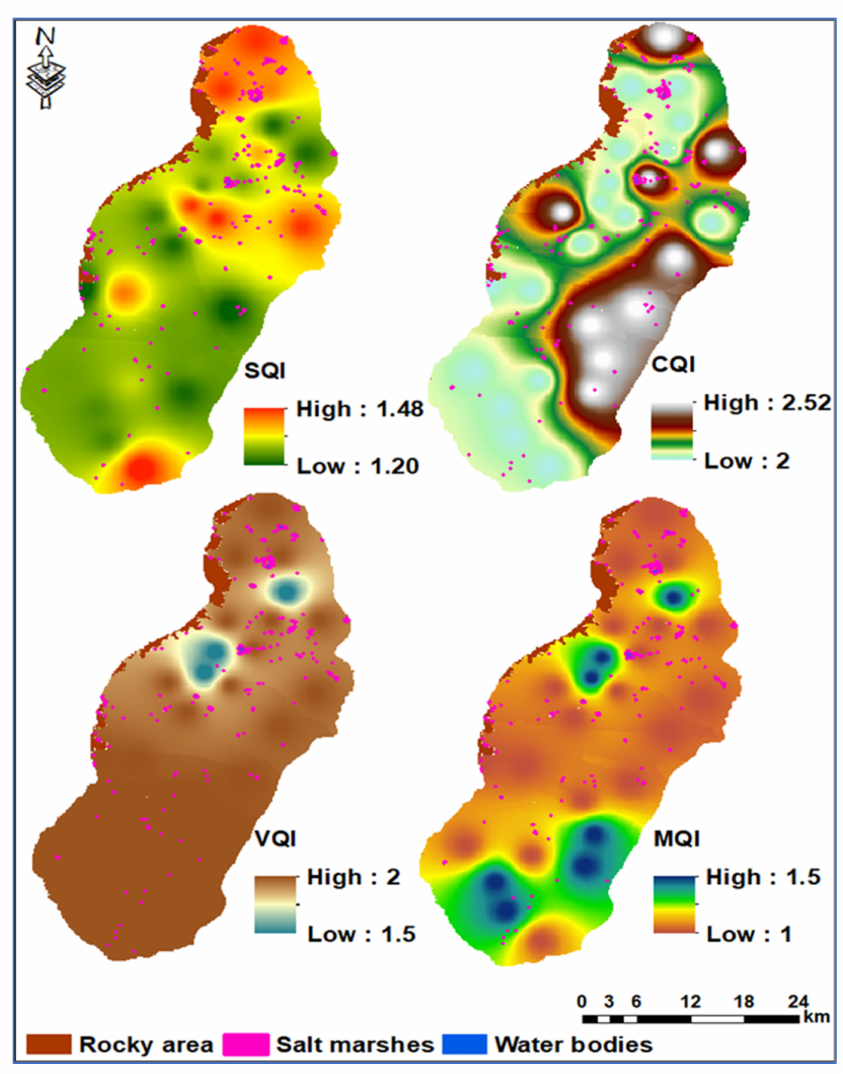
Figure 5. The four original quality indices used in the MEDALUS